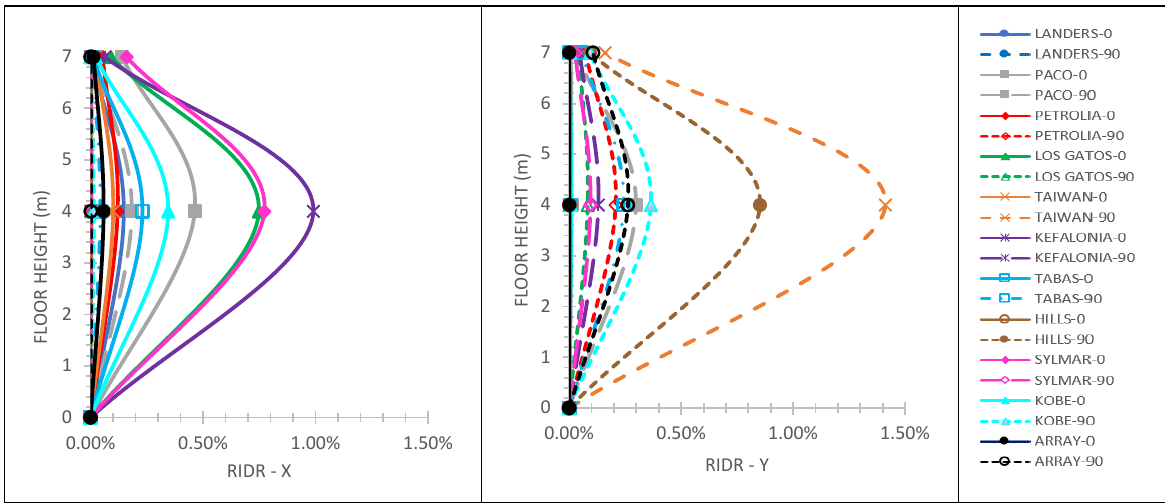
Figure 3. RIDR along X ( left ) and Y ( right ) horizontal directions of the two-story mixed building, considering the fixed connection of the steel structure to the r/c one.